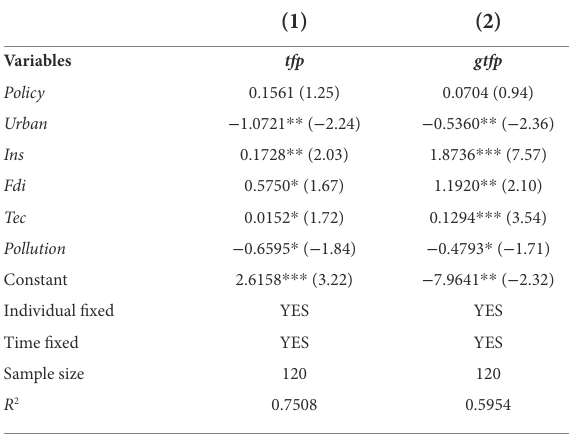
TABLE 5 Placebo test regression